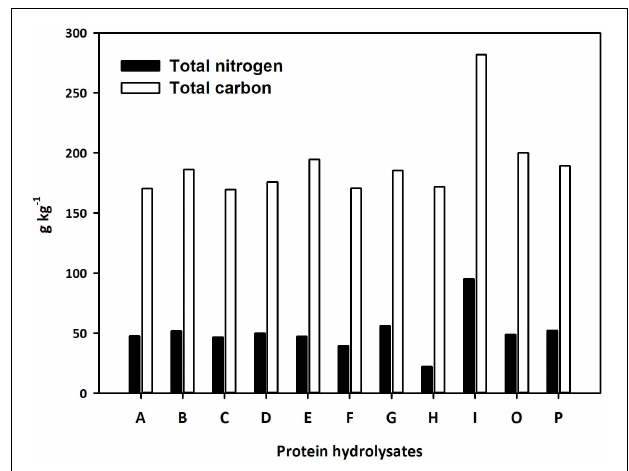
FIGURE 2 | Total nitrogen and carbon content of the 11 protein hydrolysates selected for seed